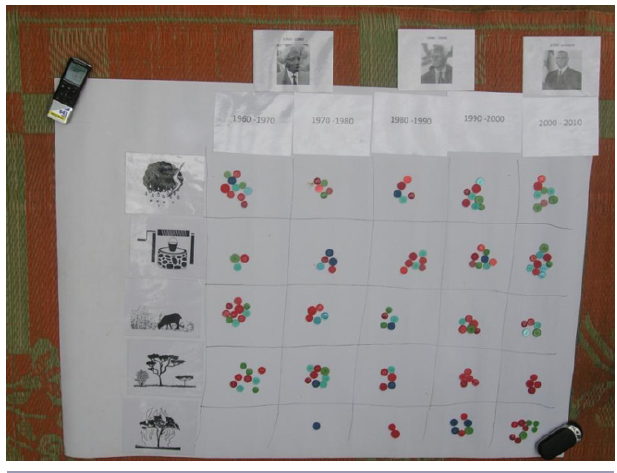
Fig. 3. A matrix of environmental variables (rainfall, water availability, pasture quality, tree densities, and bush fires) filled in by a focus group. Each variable (row) is symbolized by an icon. The five decades (columns) are further visualized by the terms of office of three presidents. The numbers of buttons in each grid cell indicate the magnitude of the respective variable; colors had no meaning in this